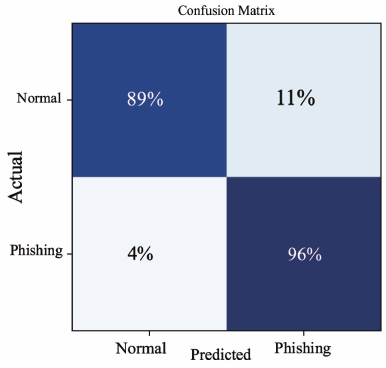
Figure 10. Confusion matrix for classification results.